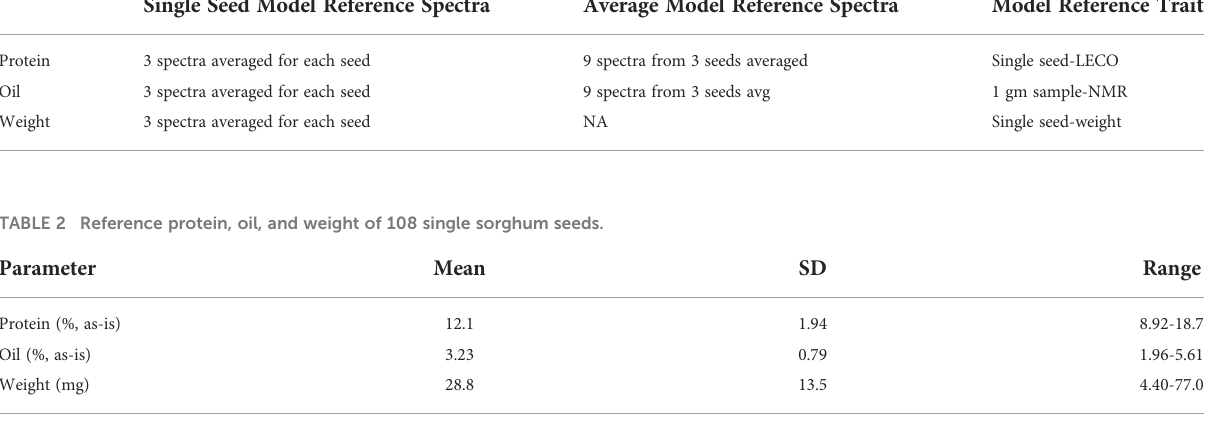
TABLE 1 PLS modelling data.